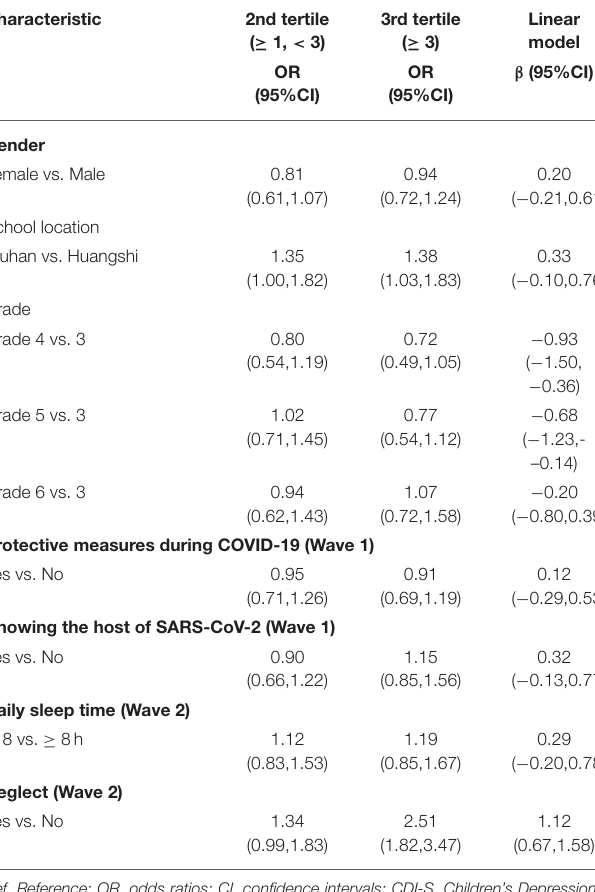
TABLE 5 | Association between demographic characteristics and difference in Screen for Child Anxiety Related Emotional Disorders ( 1 SCARED) score.